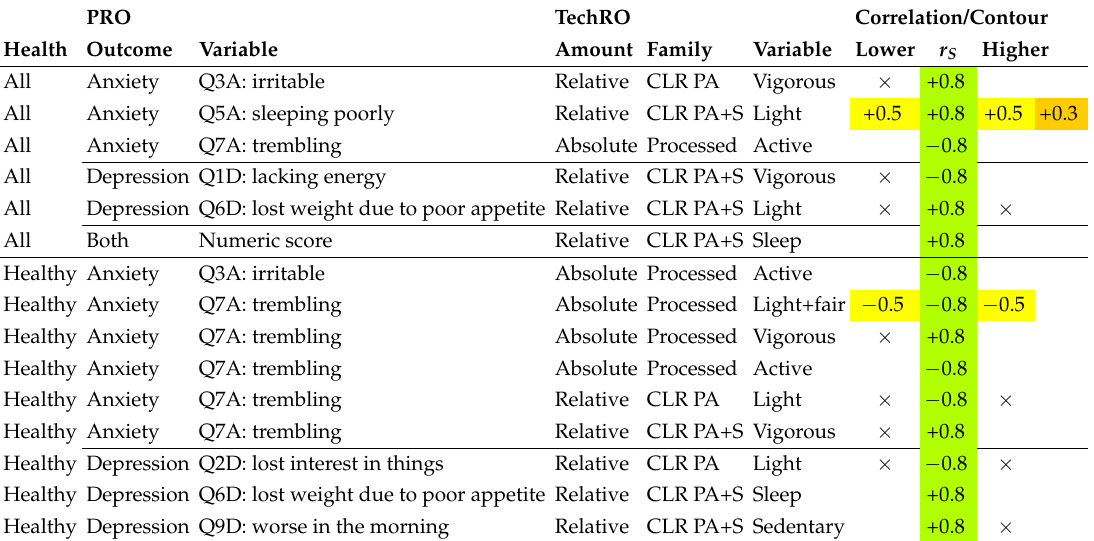
Table 9. Summary of found strong and significant Spearman rank correlations ( r S of anxiety and depression (GADS scale) and TechROs (Fitbit